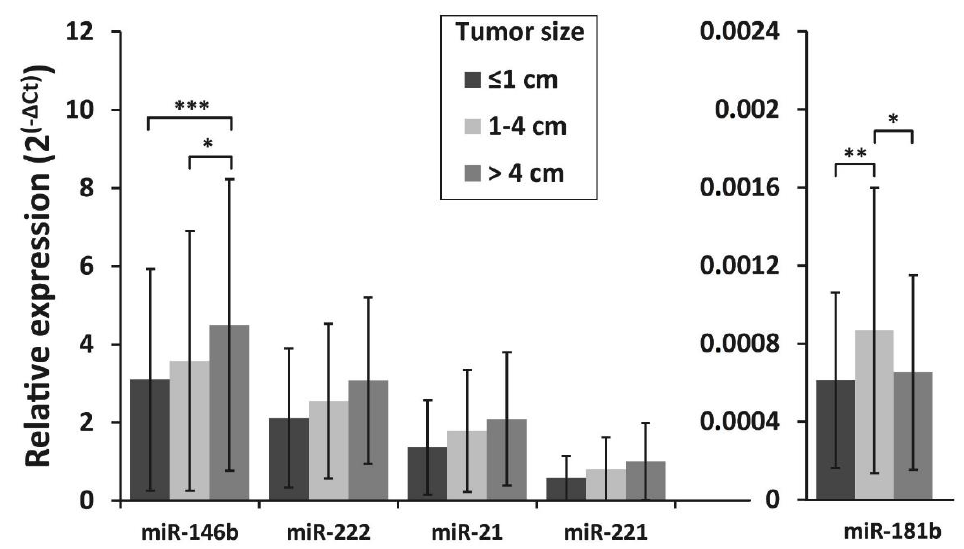
Figure 3. Relative expression levels of miR-146b, miR-222, miR-21, miR-221, and miR-181b in differently sized PTC tumors. All data are presented as the mean ± SD. * p < 0.05, ** p < 0.01, and *** p < 0.001.